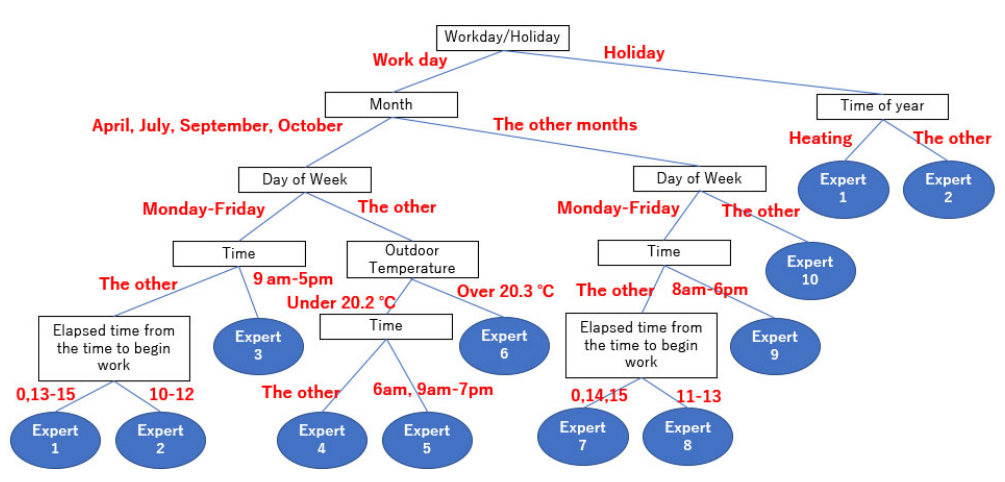
Figure 9. The prediction model for outlets by the